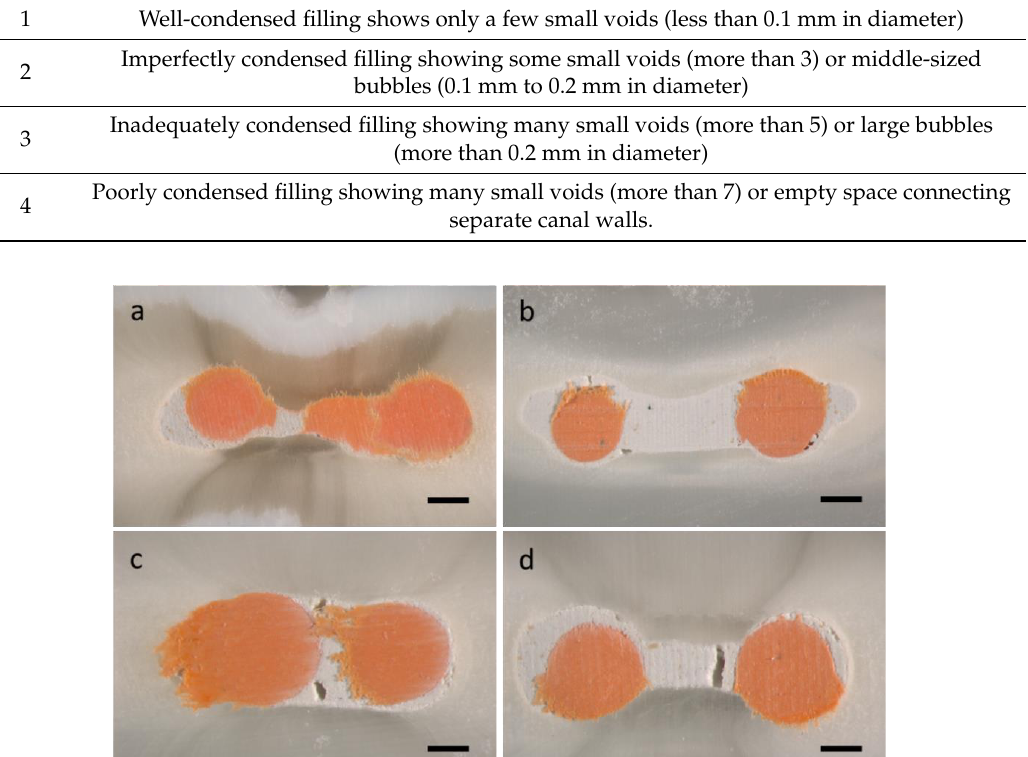
Table 1. Scoring system for the evaluation of the filling quality.